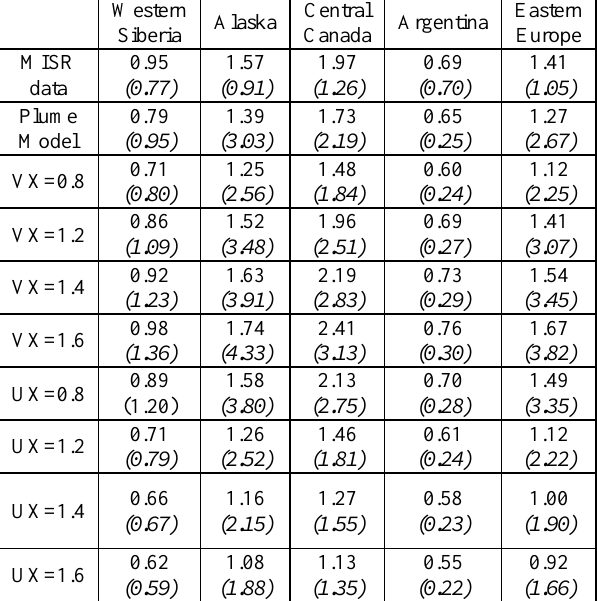
Table 3. Statistics of (top row) measured MISR plume heights and ( standard deviations ) using daily data from 2008 to 2011; (second row) the plume rise model; and various sensitivity tests with the model as a function of vertical (VX) and horizontal (YX) velocity. One important meteorological factor in terms of plume rise modeling is the wind speed, as shown in Table 3. Initially wind speed was assumed to be constant uniform over the entire vertical rise of the plume. However, given how high these plumes rise, such an assumption may no longer be valid, as winds in the lower free troposphere are frequently different from in the boundary layer. Therefore, a sensitivity analysis can help us to understand the impact of such assumptions on the model’s ability to predict the plume heights. For Argentina, East Europe and West Siberia, the change of wind speed factor has little impact on the RMS (about 0.4, 0.8 and 0.7 respectively for Argentina, East Europe and West Siberia). But the best-fit wind factors (in terms of root mean square error (RMS)) are found to specifically be VX=1.6,RMS=1.10km for Central Canada